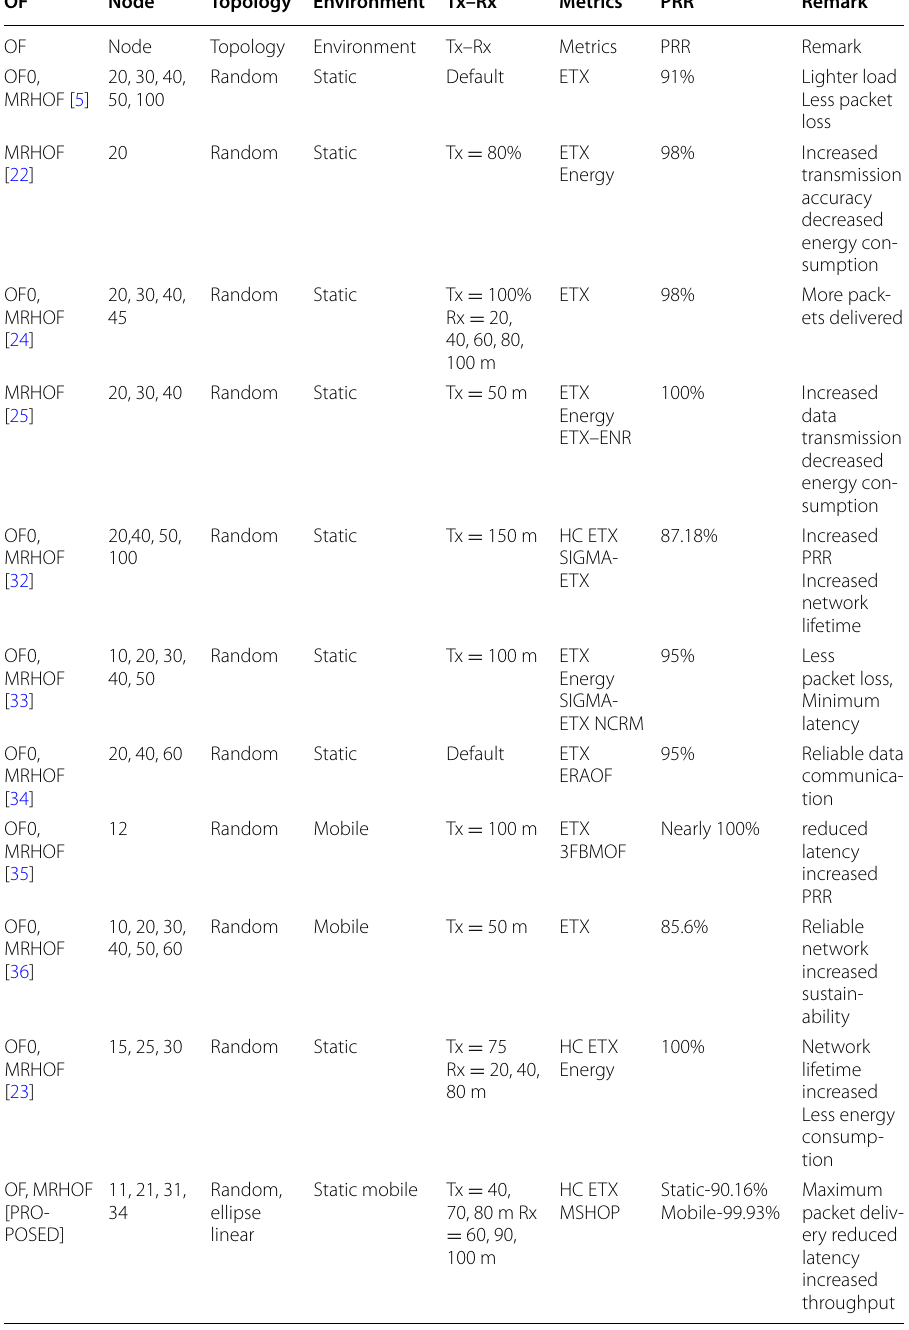
Table 1 Objective functions-related assessment research OF Node Topology Environment Tx–Rx Remark OF Node Remark OF0, 20, 30, 40, MRHOF [5] 50,